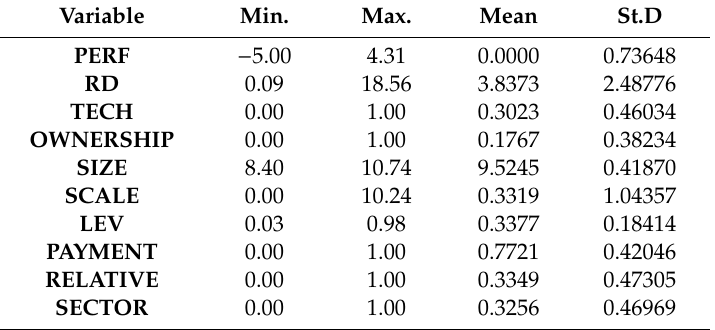
Table 3. Description of the variables. PERF: acquisition performance, RD: R&D, TECH: acquisition motive, OWNETSHIP: corporate ownership, SIZE: firm size, SCALE: acquisition scale; LEV: financial leverage, PAYMENT: payment method, RELATIVE: transaction type, SECTOR: